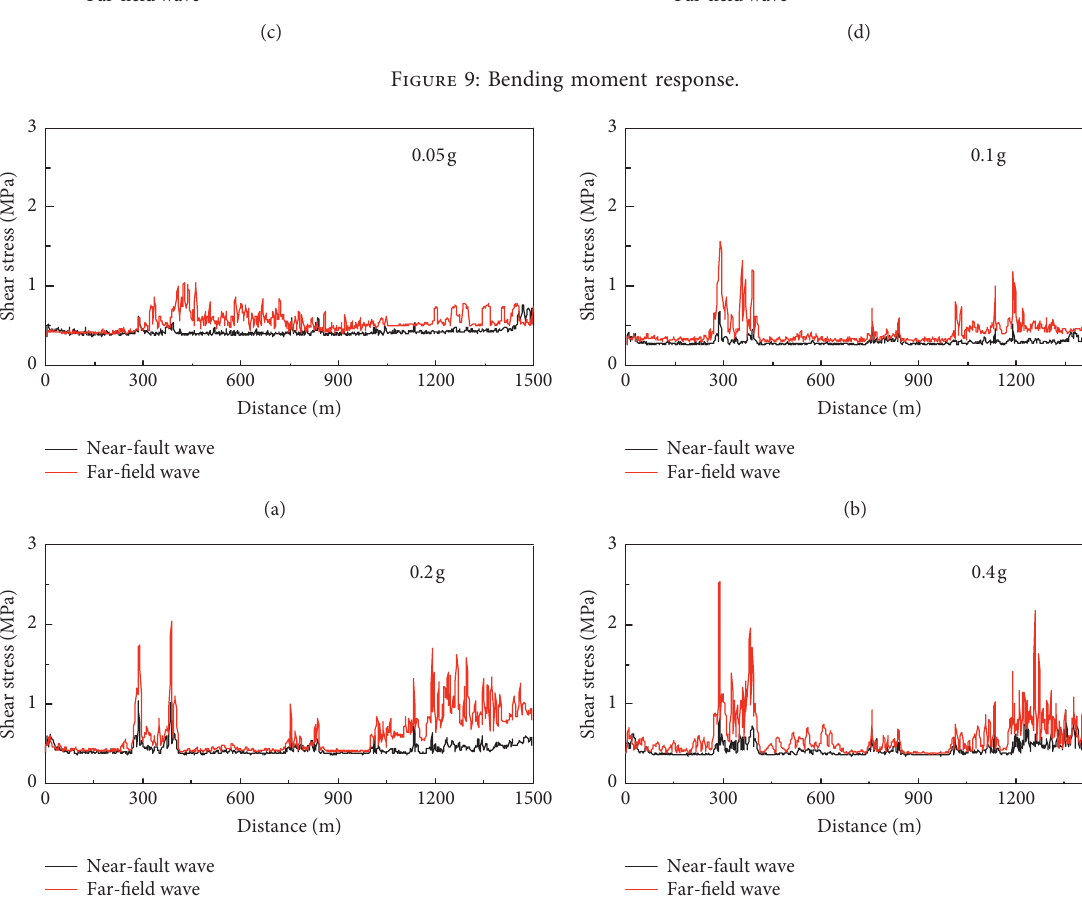
Figure 9: Bending moment response.